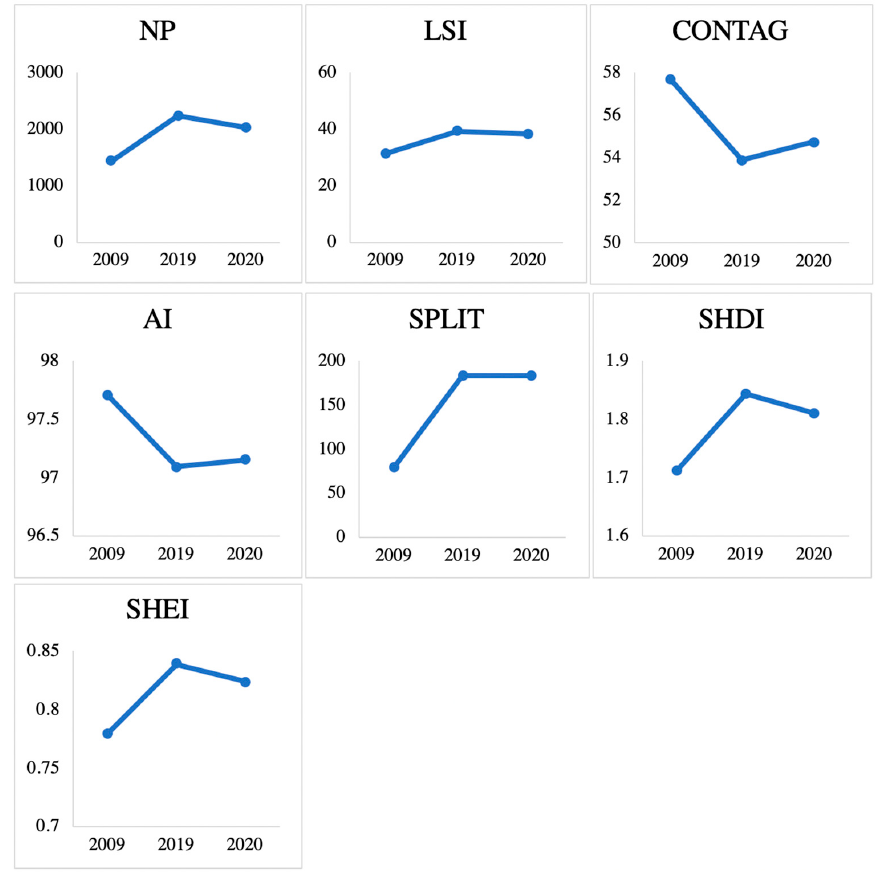
Figure 8. Changes in landscape metrics at landscape level. NP: number of patches; LSI: landscape shape index; CONTAG: contagion index; AI: aggregation index; SPLIT: splitting index; SHDI: Shannon’s diversity index; SHEI: Shannon evenness index.